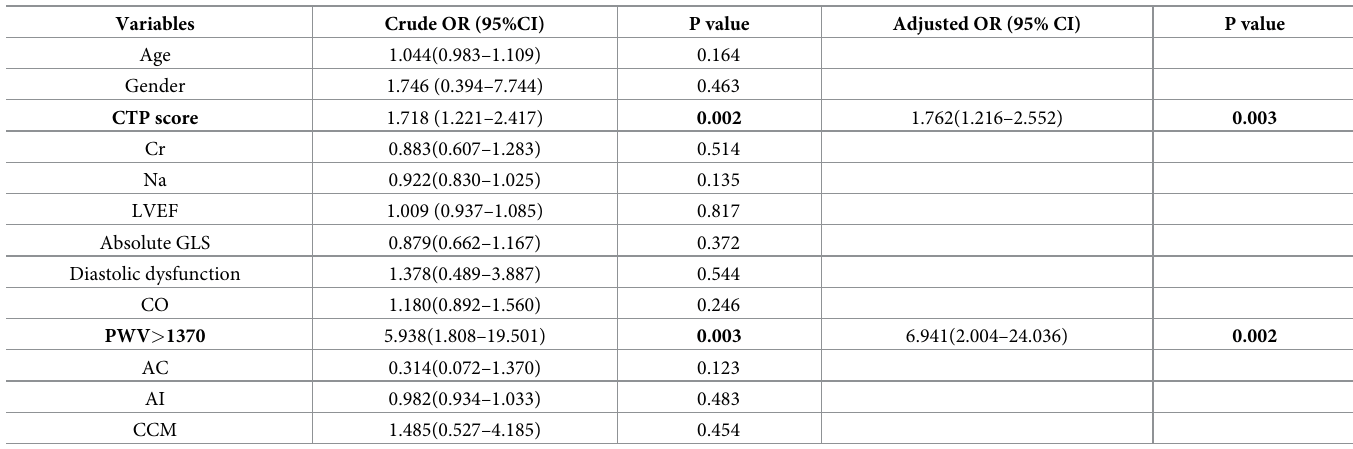
Table 4. Odds ratios for overall mortalities in decompensated cirrhosis in relation to demographic and cardiac variables (Cox regression). Variables